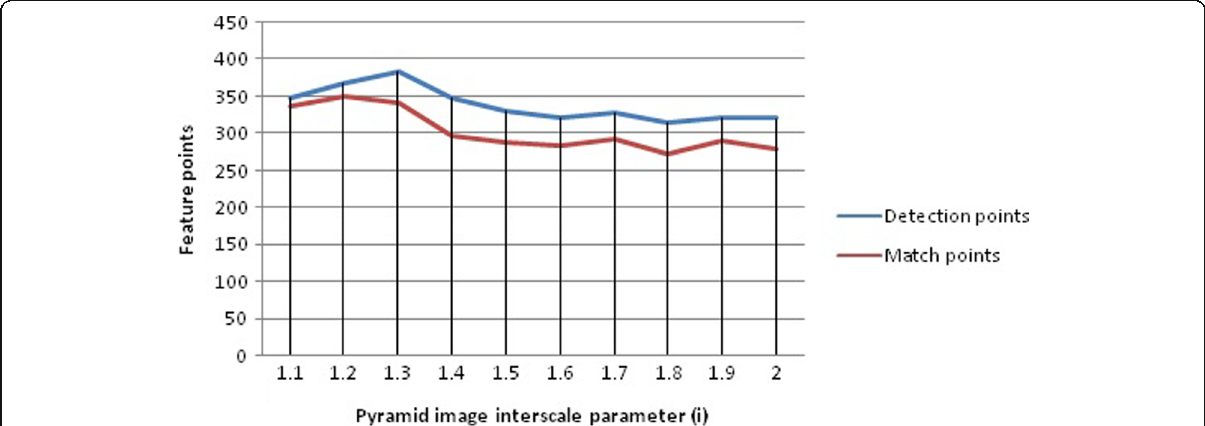
Fig. 14 Comparison of the number of feature points detected and the number of exact matches when the scale parameters of the pyramid image